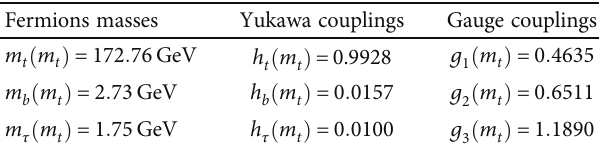
Table 2: Numerical values for fermion masses, Yukawa, and gauge scale. couplings at m t